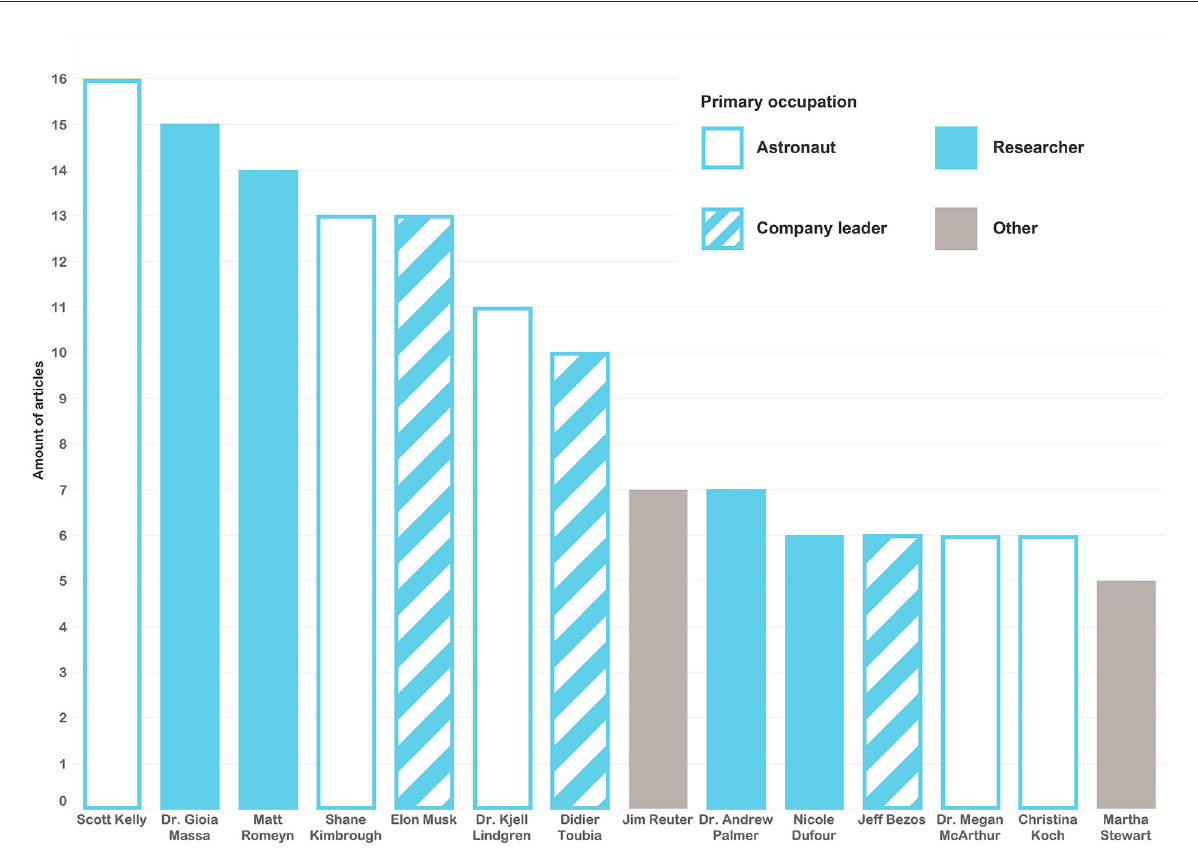
FIGURE3 People mentioned in five or more articles in the word frequency analysis, showing primary occupations (astronaut, researcher, company leader, and